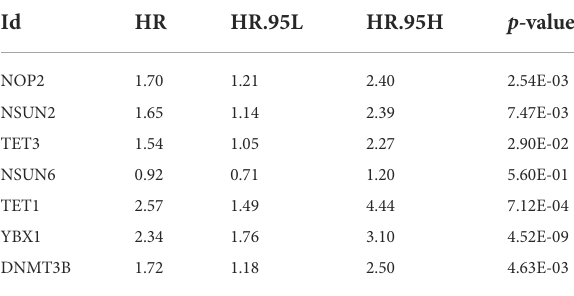
TABLE 2 Univariate Cox regression